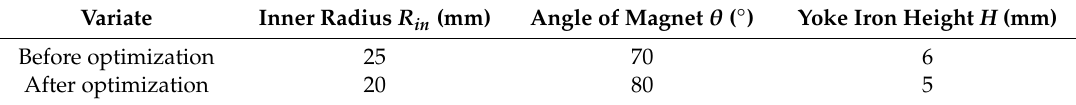
Table 1. Comparison of magnetic wheel characteristics before and after optimization. Variate Before optimization